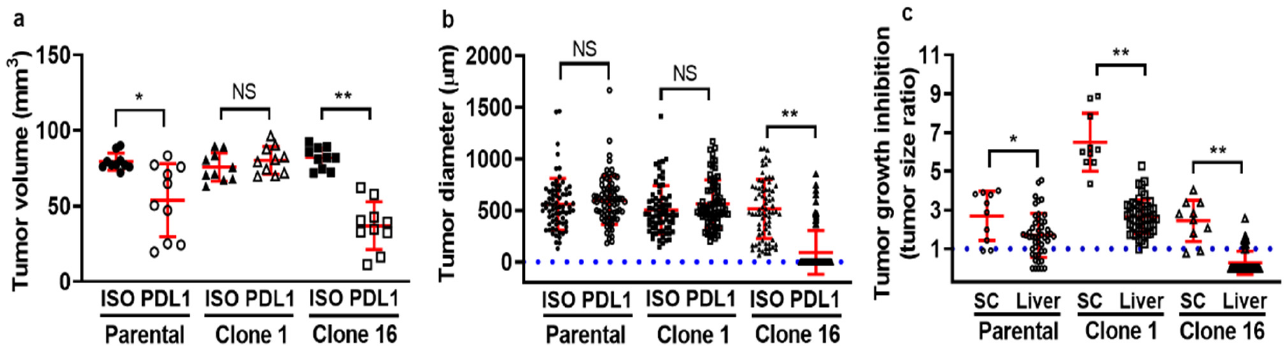
Figure 2. Determine seed- and soil-dependent differences in the therapeutic efficacy of tumor-bearing mice treated with either isotype control or anti-PD-L1 IgG. First, parental, clone 1, or clone 16 cells, were inoculated into the mammary fat pad (mfp) or spleen to produce primary tumor or experimental liver metastasis models. The tumor-bearing mice were then treated with either isotype control or anti-PD-L1 IgG on days 7 and 10. Primary tumor growth ( a ) and liver metastases growth ( b ) are shown. Tumor growth inhibition was determined by calculating the ratio of tumor volume or size between the endpoint to the initial time point ( c ). (* p < 0.05; ** p < 0.001 with respect to the isotype control IgG-treated mice and anti-PD-L1 IgG-treated mice; NS: no significant difference).